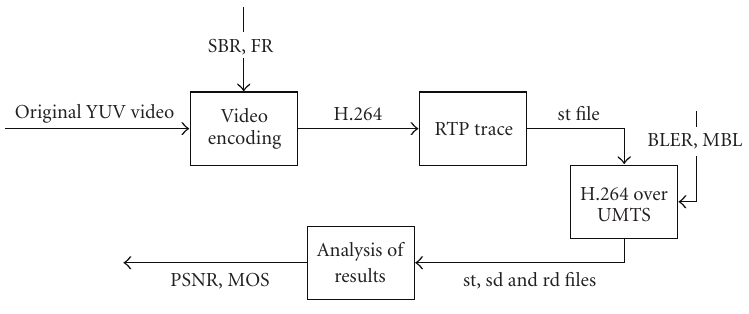
Figure 11: Simulation methodology. Table 3: Simulation parameters.